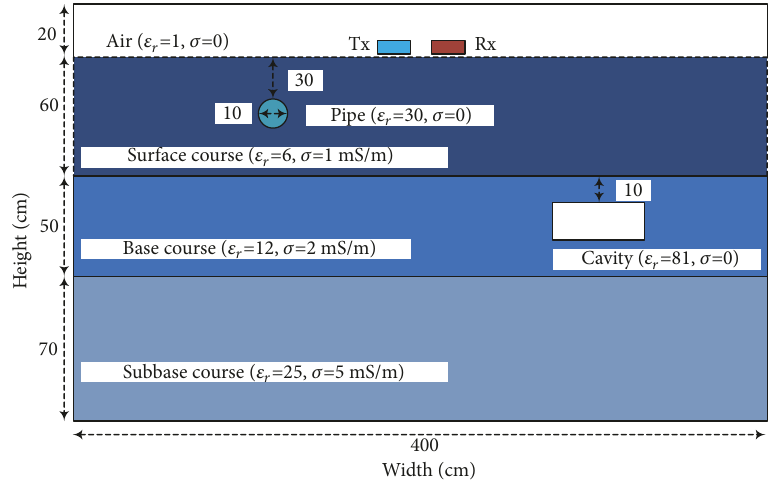
Figure 14: A sketch of the structural damage pavement GPR model simulated in this work.